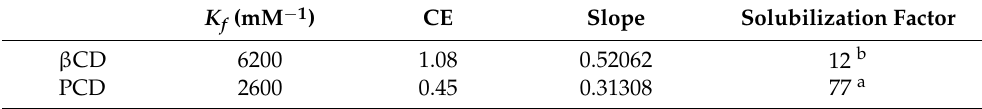
Table 1. Association constant ( K f ), complexation efficiency (CE) and slope values of β CD and